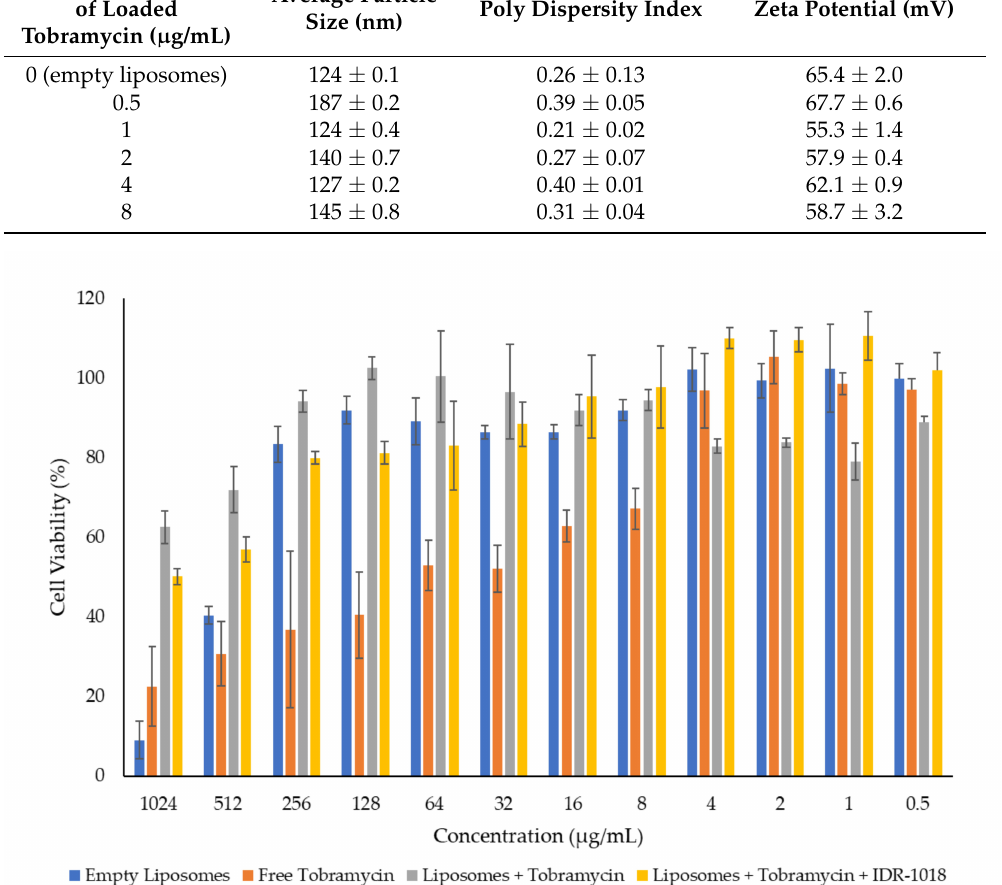
Figure 1. Cell viability of different concentrations of empty liposomes, free tobramycin, liposomes loaded with tobramycin, and liposomes loaded with both tobramycin and IDR-1018 peptide upon 48 h exposure with A549 cells. Results are represented as the mean ± SD (n =